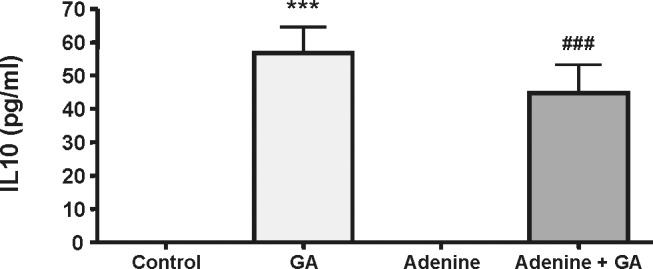
Interleukin 10 (IL-10) concentration in the plasma of control rats, rats treated with gum arabic (15% w/v in drinking water) and rats treated with adenine (0.75% w/w) alone in feed, or with adenine and gum arabic given concomitantly at the same dose for 28 days.Each column and vertical bar represents the mean ± SEM (n = 6). *** p<0.001 vs. control, ### p<0.001 vs. adenine treatment.